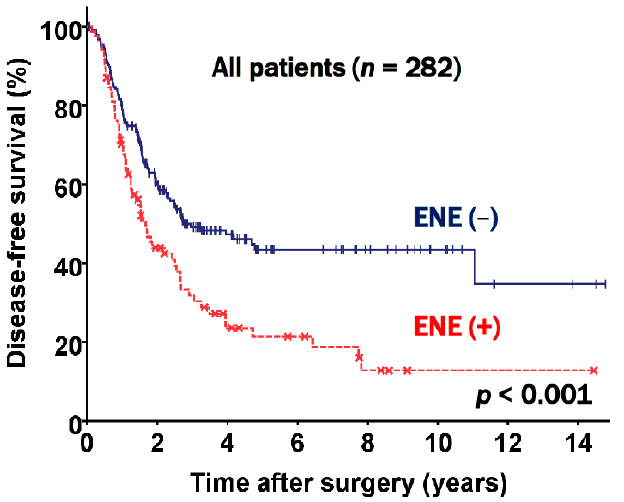
Figure 2. Disease free survival curve according to extranodal extension (ENE)